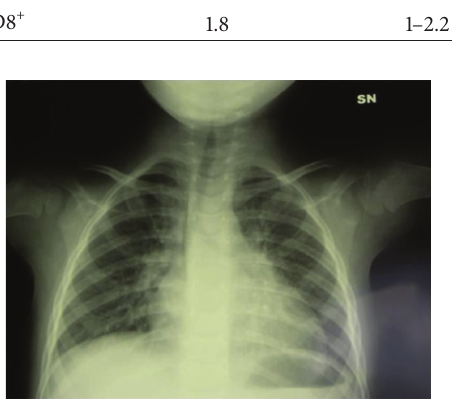
Figure 1: Chest X-ray: the chest X-ray showed reinforcement of the bronchial tree shadows, no bronchiectasis, and a markedly reduced thymic image.